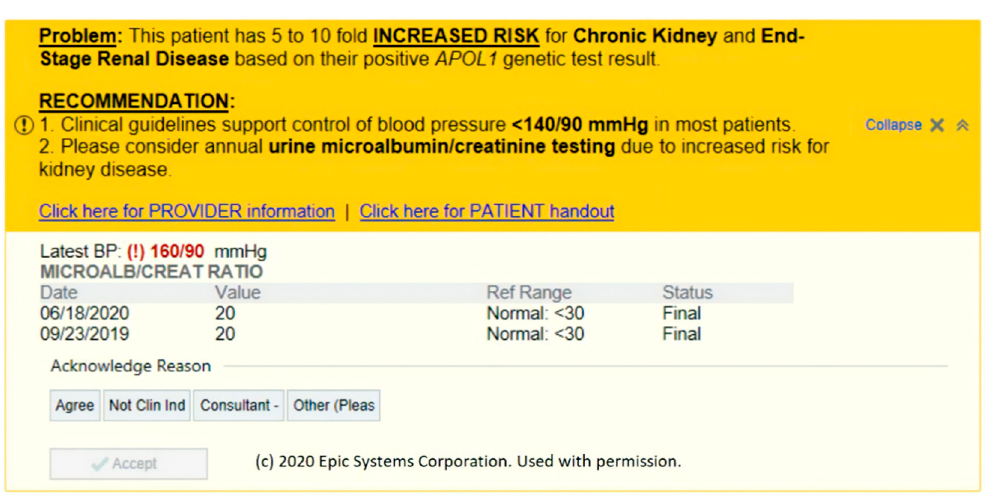
Figure 2. An example alert for APOL1 in response to an elevated BP with a normal albumin/creatinine ratio.